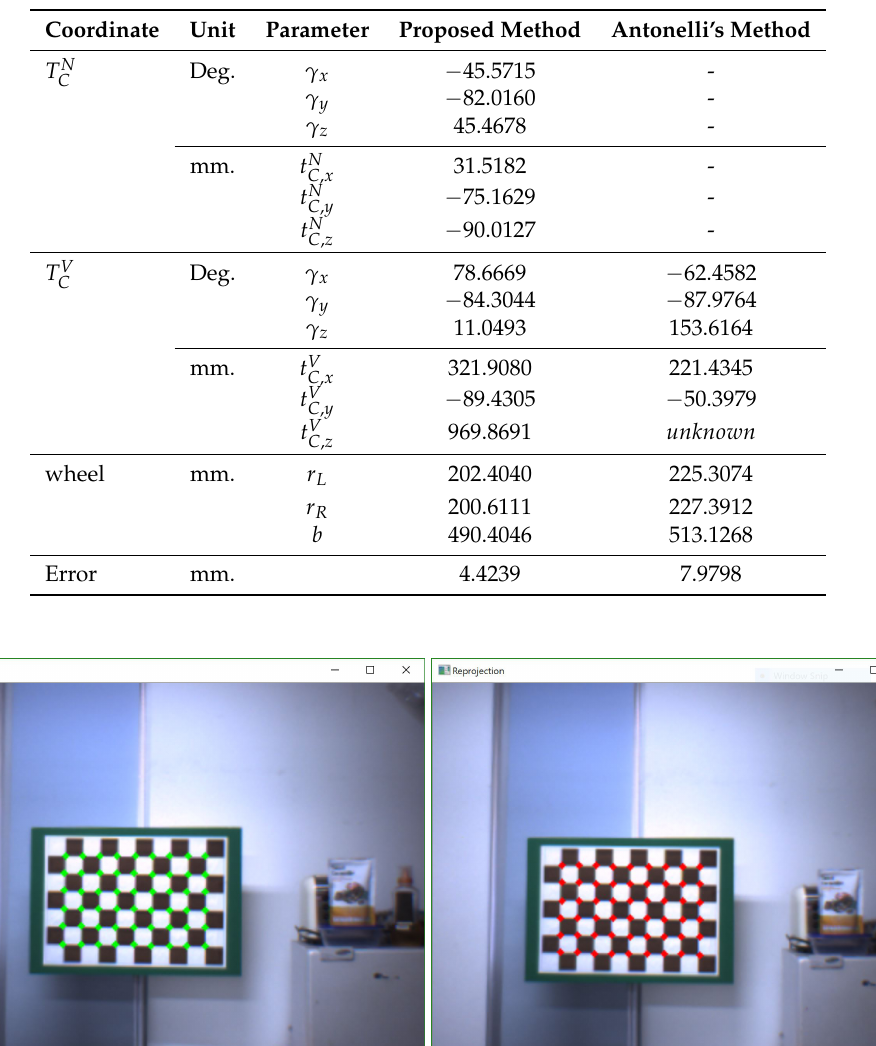
Figure 4. Natural features matching. Table 1. Results of the proposed method and Antonelli’s method.